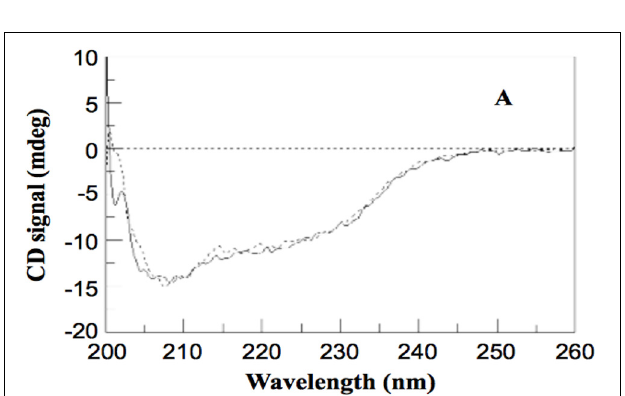
FIGURE 2 | CD Spectrum showing intact structural integrity of an encapsulated protein relative to WT (Swed et al., 2014) – Published under Creative Commons Attribution License, which permits unrestricted use, distribution, and reproduction of figure in any medium.